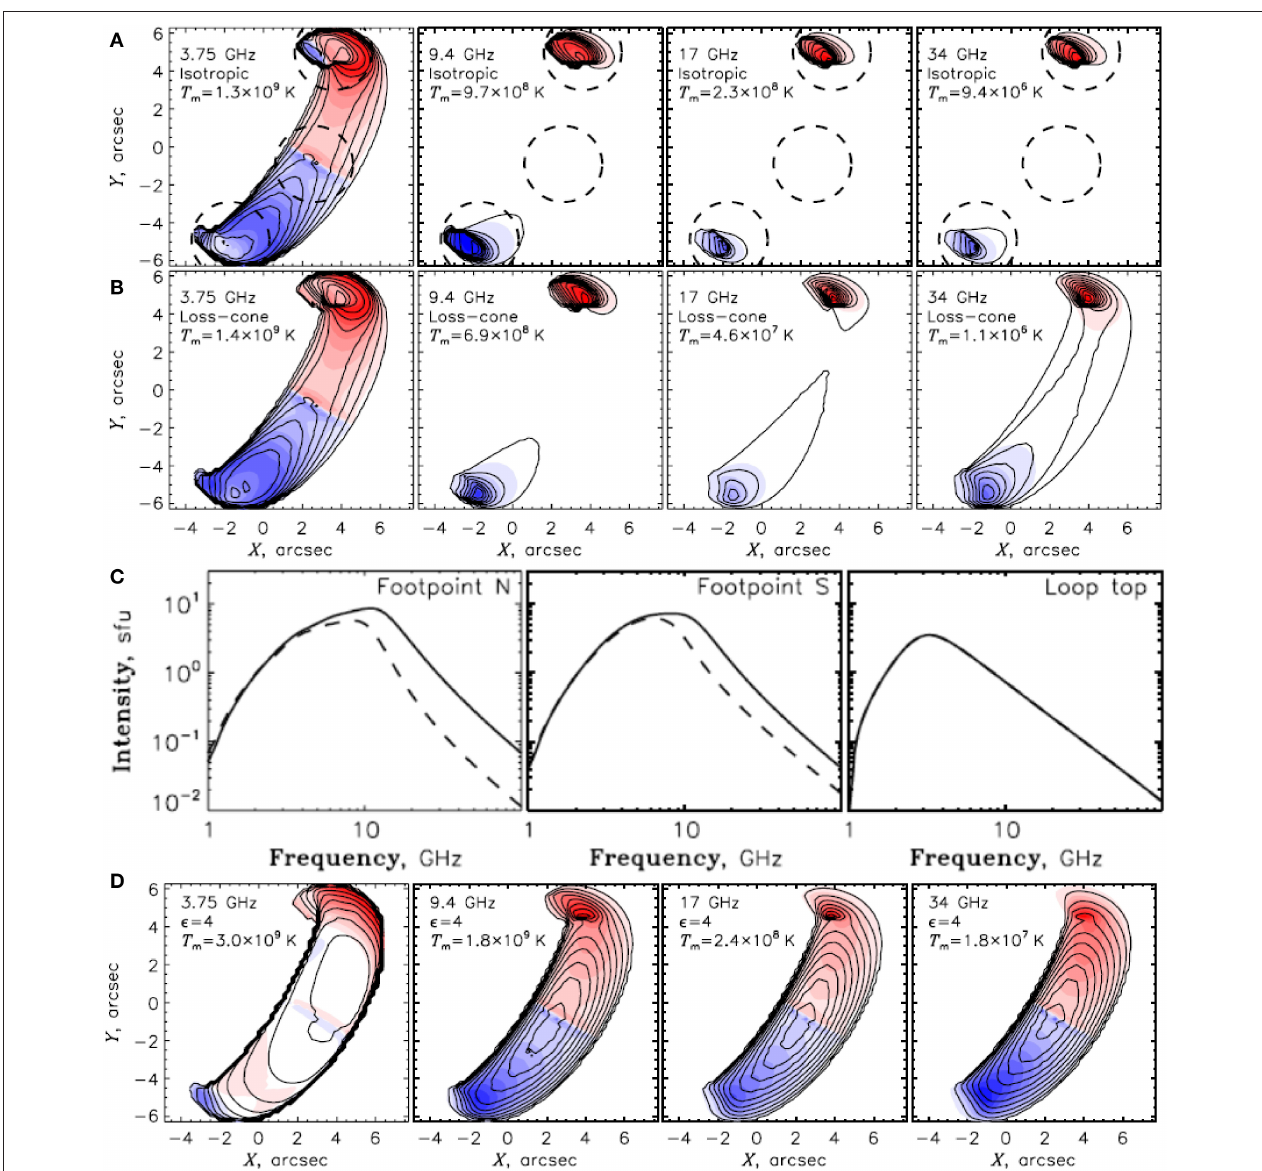
FIGURE 13 | Brightness temperature maps of the gyrosynchrotron emission from a model loop for an isotropic electron pitch-angle distribution (A) , and a loss-cone pitch-angle distribution (B) . In both cases the density of the accelerated electrons is constant along the loop. (C) Flux density spectra of the northern footpoint source (left), southern footpoint source (middle) and loop top source (right) resulted from the models of rows (A,B) (solid lines and dashed lines, respectively). These spectra were computed in the areas defined by the dashed circles of row (A) . (D) Same as row (B) but with an inhomogeneous spatial profile of the electron density along the loop. In rows (A,B,D) , the contours denote intensities evenly distributed from zero to the maximum brightness temperature which is given in each panel. The red and blue colors denote the circular polarization (right and left sense, respectively). Adapted from Kuznetsov et al. (2011). © AAS. Reproduced with